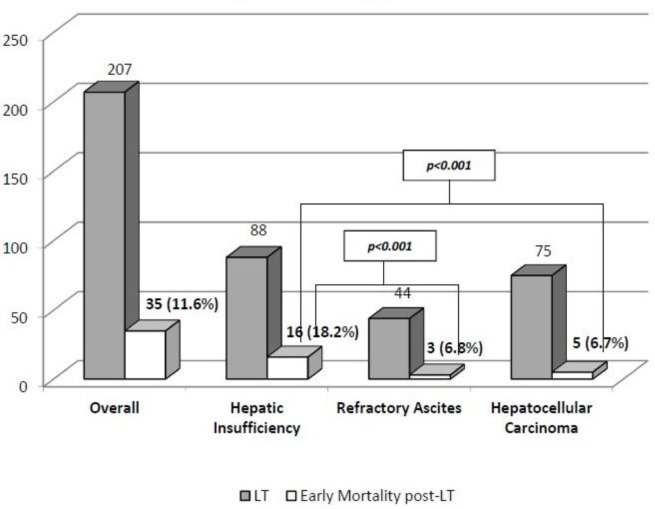
Early mortality post-LT